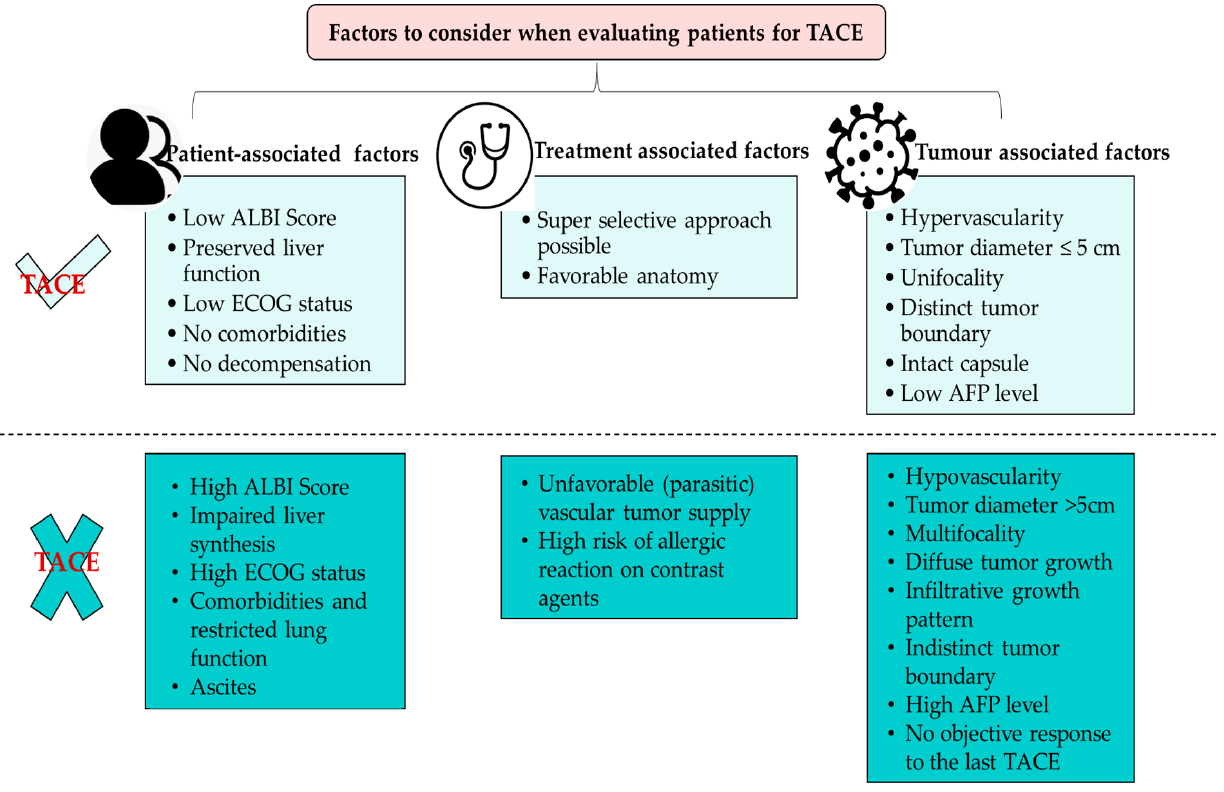
Figure 3. Overview of prognostic factors for patient selection for TACE. Figure adapted from Müller L et al., JHC2021 [84]. AFP, alphaa-fetoprotein; ALBI, albumin-bilirubin; ECOG, Eastern Coopera-